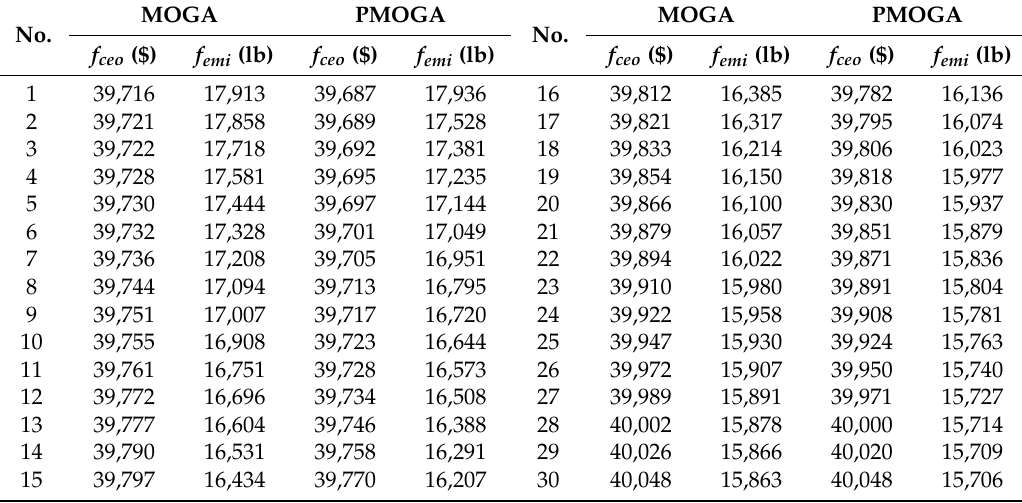
Table 1. The non-dominated schemes obtained by different methods for Case 1.